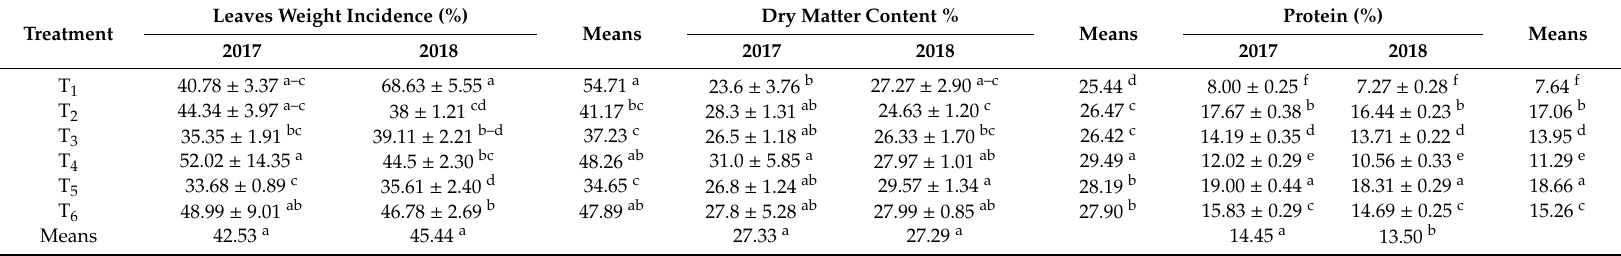
Table 5. E ff ect of organic, inorganic, and biofertilizers on plant growth characteristics and chemical contents (leaves weight incidence, dry matter content, and protein) of Jew’s mallow ( Corchorus olitorius L.) plants.